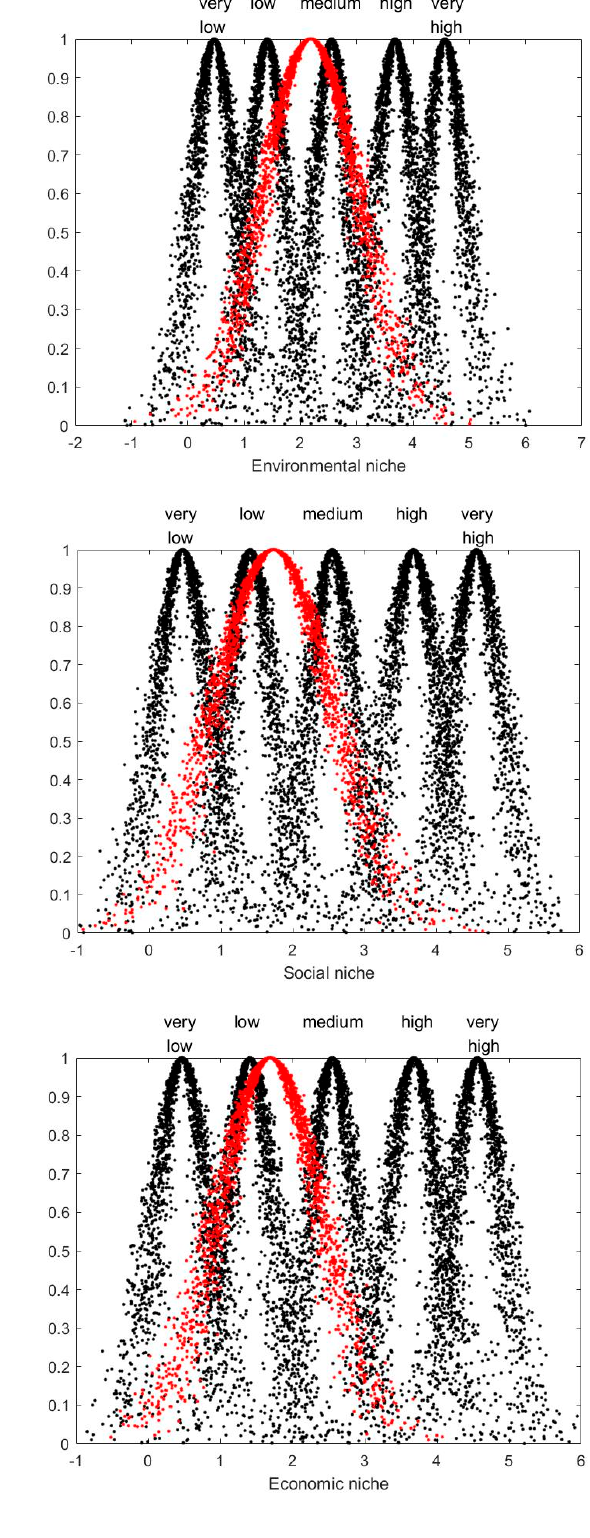
Figure 6. Niche cloud map of secondary each indicator.